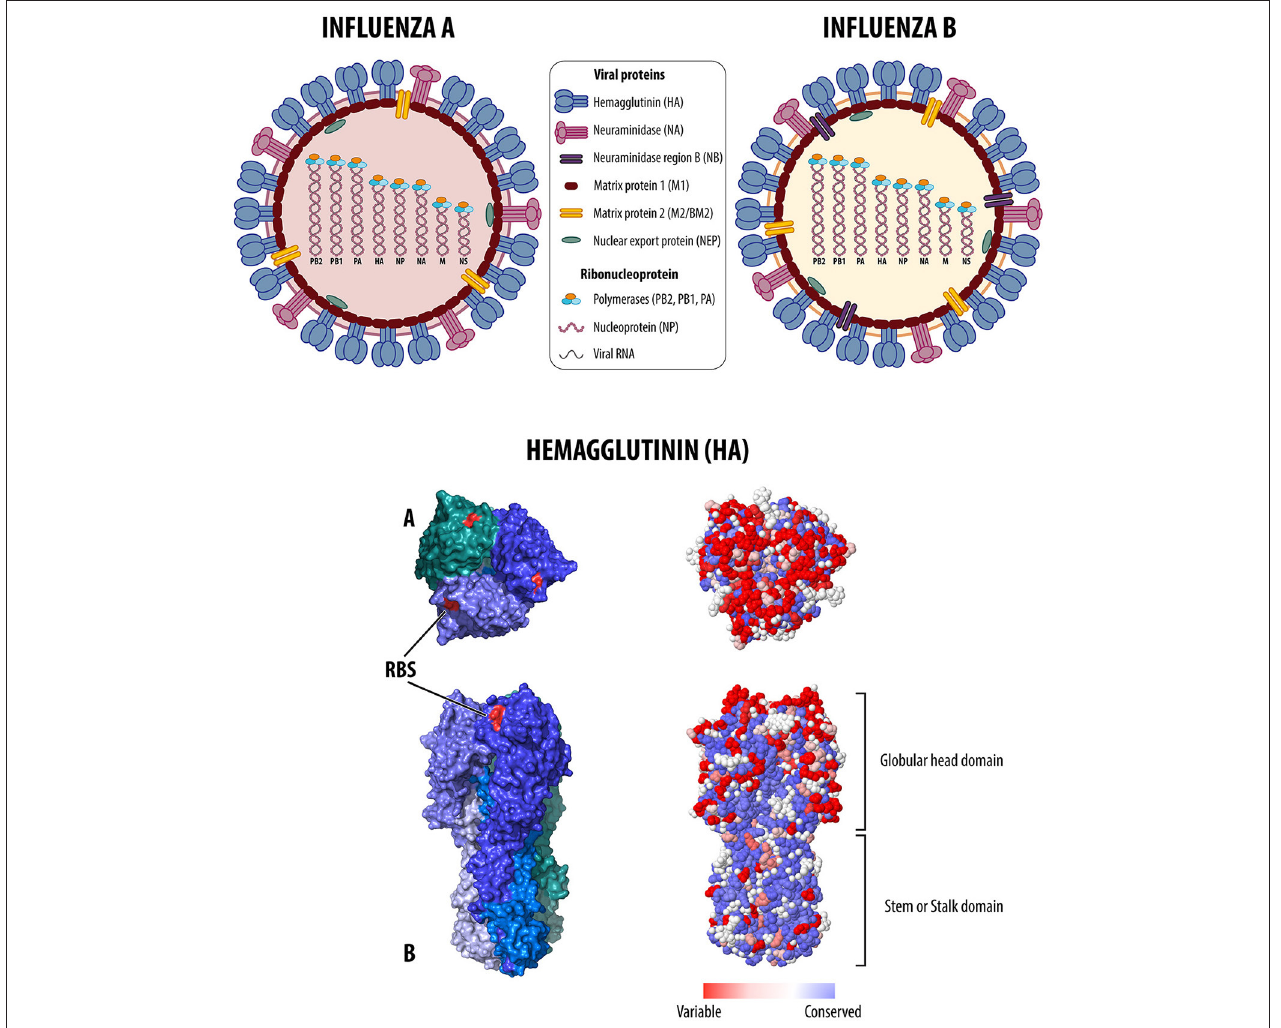
FIGURE 1 | (Top) Schematic structure and genome organization of influenza A and B viruses. Haemagglutinin (HA), neuraminidase (NA), matrix protein 2 (M2/BM2), neuraminidase region B (NB) are on the surface of the virus particle. Matrix protein 1 (M1) is associated with the membrane. Ribonucleoprotein complex formed by RNA segments, nucleoprotein (NP) and viral polymerases (PB2, PB1, PA). Non-structural nuclear export protein (NEP). (Bottom) The 3D molecular structure of the HA glycoprotein trimer from A/Hong Kong/1/68 (H3N2) (PDB 5T6N), top (A) and side (B) views (structure modified and colored using MacPymol, Schrodinger, LLC). Each monomer has a globular head domain and a stem/stalk domain. On the left panels each monomer is shown with a different color. The receptor binding site (RBS) is highlighted in red. On the right panels, residue conservation for every position in the protein sequence is shown in a color scale, and visualized using the 3D tool available at the Influenza Research Database